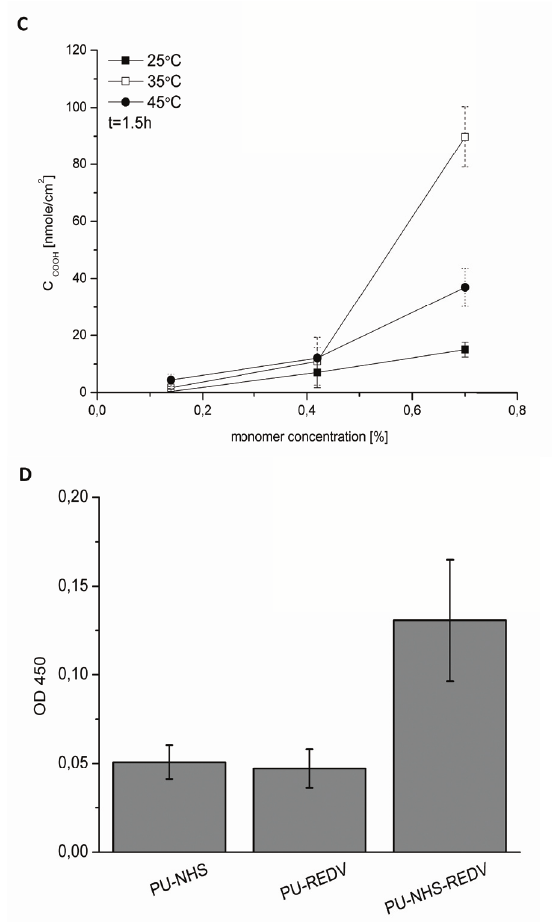
Figure 3: c) Concentration of COOH groups on the polyurethane (PU) surface aft er acrylic acid (AA) graft ing as a function of monomer concentration. MV±SD, n=10; d) REDV peptide presence on carboxylated PU surface confi rmed by ELISA test. MV±SD,